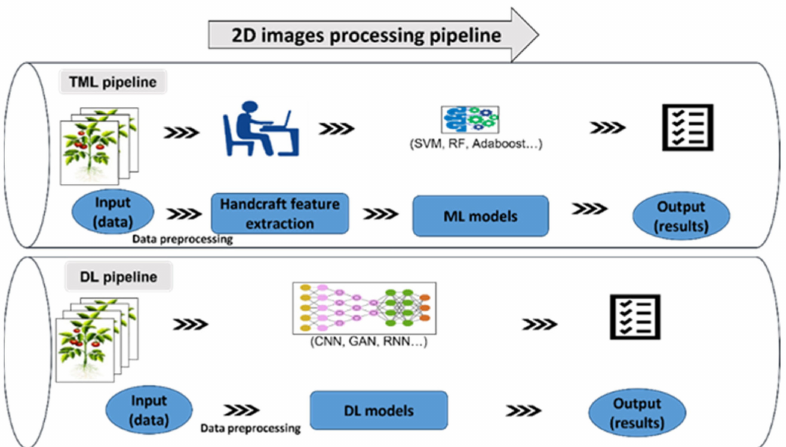
Figure 4. Two -dimensional image processing pipeline based on traditional machine learning (TML) and deep learning (DL). TML processing flow includes: data preprocessing, feature extraction, choosing the ML model, training the model, and finally obtaining the well-trained model (satisfying the accuracy). DL processing flow includes: preparing datasets and data preprocessing, choosing the DL model, training the model, and finally obtaining the well-trained model. As for the deployment of DL models for plant stress phenotyping, three strategies are presented, ranging from directly using pre-trained models to designing a custom model from